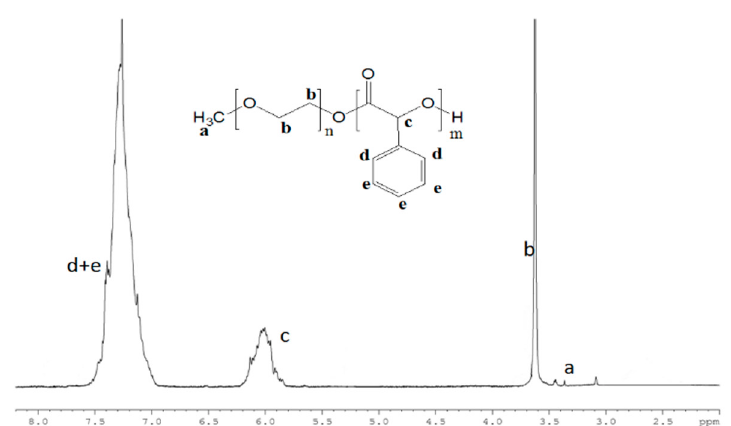
Figure 1. Nuclear magnetic resonance ( 1 HNMR) spectra of copolymer Polyethylene glycol monomethyl ether-Polymandelic acid (mPEG-PMA).